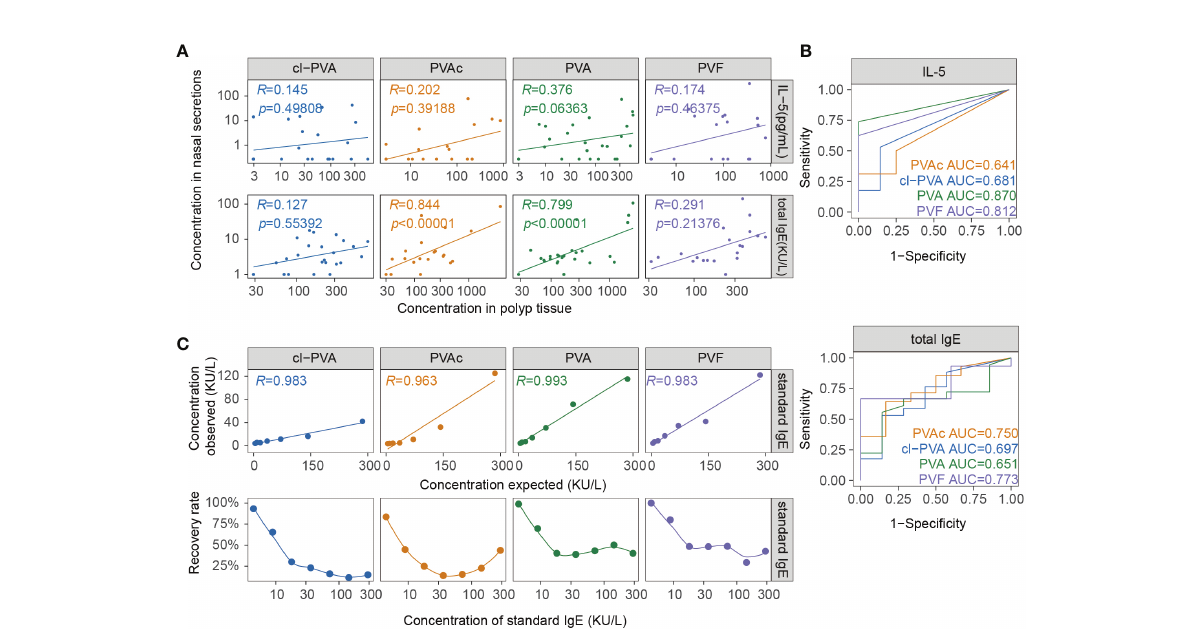
FIGURE 1 Comparison of IL-5 and IgE levels in nasal secretions collected by 4 types of nasal packs. (A) Correlation between total IgE and IL-5 (Group1, n = 89) in nasal secretion and tissue collected by 4 types of nasal packs. (B) Receiver operating characteristic curves of IL-5, total IgE in nasal secretion (Group1, n = 89), using concentrations in tissue homogenate as gold standards. (C) Correlation and recovery rate of standard IgE in nasal secretion collected by four types of nasal packs. PVA, polyvinyl alcohol; PVAc, polyvinyl acetate; cl-PVA, cross-linked PVA; PVF, polyvinyl fl